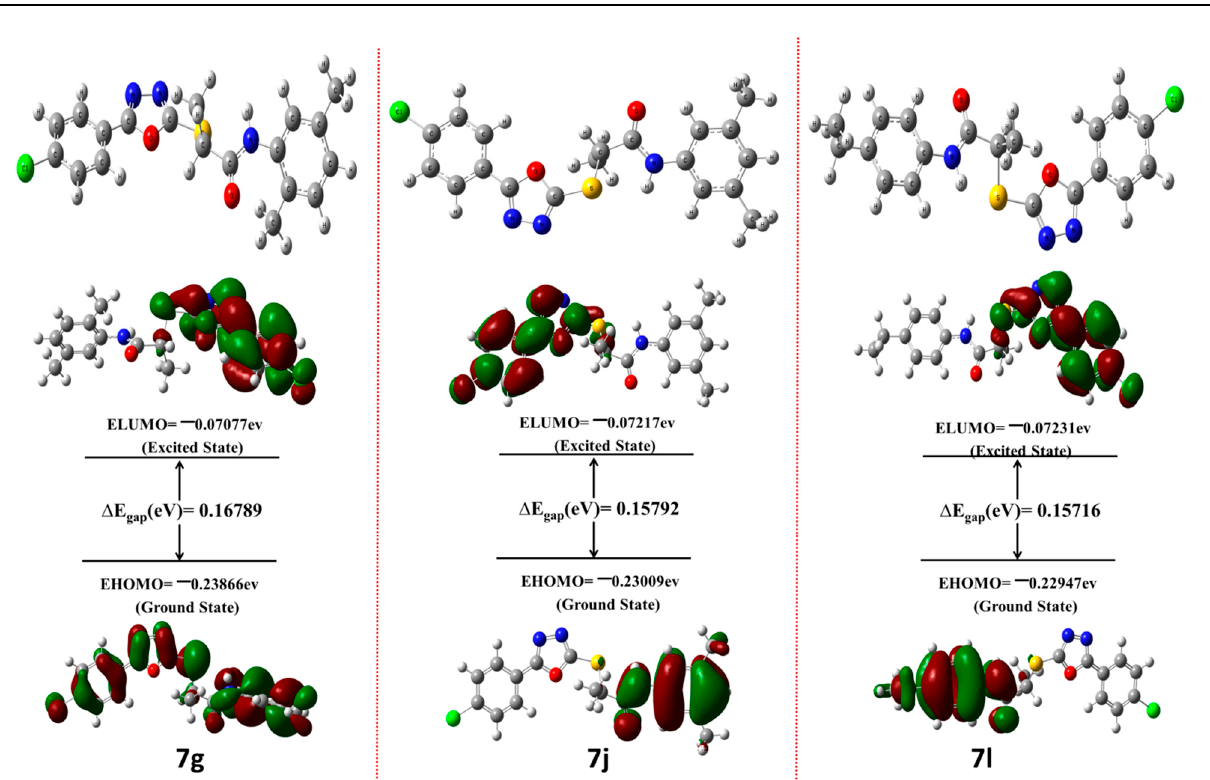
Figure 4. Optimized structures along with different energy transitions for 7g , 7j and 7l. The transition of energy is depicted in green and red color around the atoms of evaluated compounds. The green color indicates the negative periods, while the red color represents the positive periods. The optimized structures of selected 1, 3, 4 oxadiazoles derivatives are given in Supplementary File (Figures S1–S3).